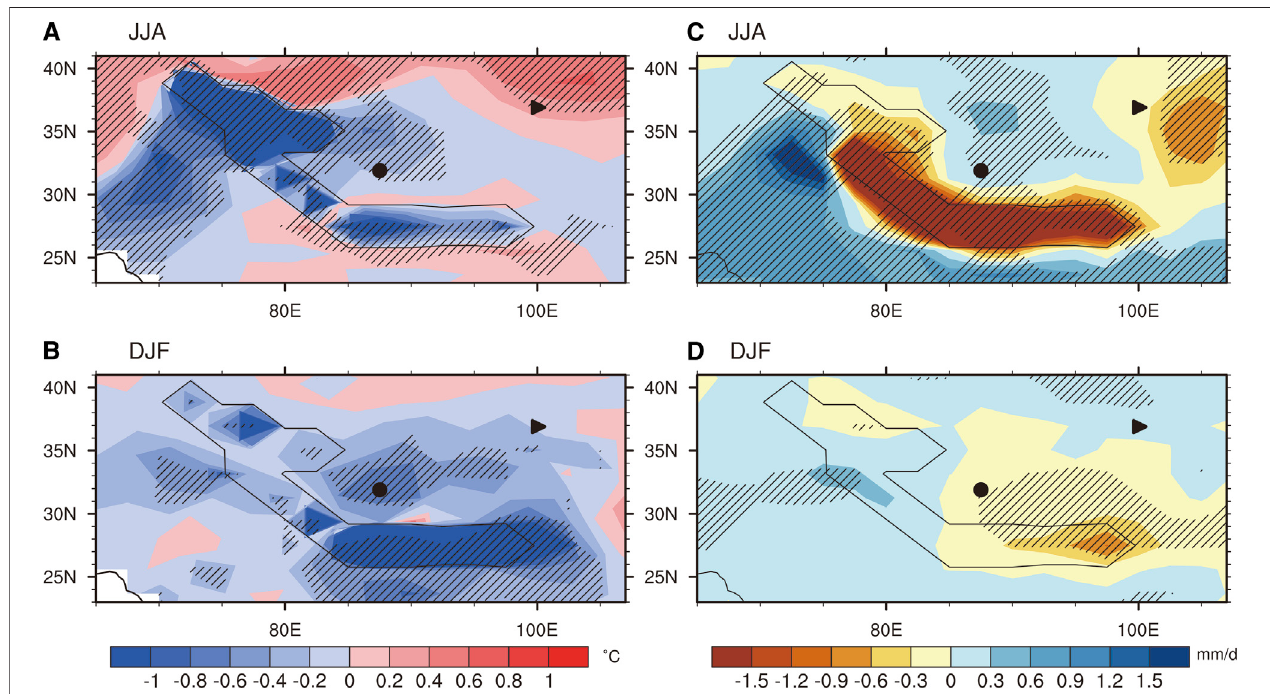
FIGURE 6 | Changes in summer (June-August) and winter (December-February) surface temperatures (A and B) and precipitation rates (C and D) due to the glacier expansions over the TP during the LGM. The thin black line polygon is the region where glaciers expanded. Regions where the temperature or precipitation rate changed at the 0.05 level of signi fi cance are hatched. The black dot represents the location of Dagze Co on the southern TP, while the black triangle represents the location of Qinghai Lake on the northern TP. This fi gure is modi fi ed from Liu et al. (2020).